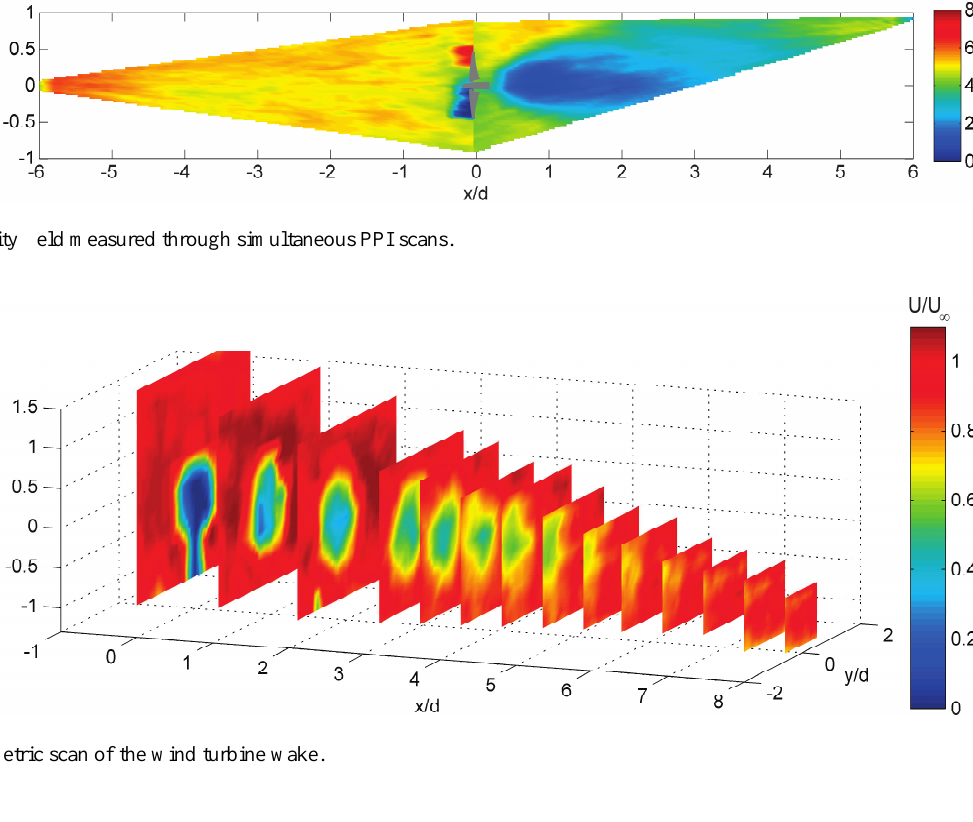
Figure 2. Vertical velocity profiles obtained through simultaneous RHI scans.